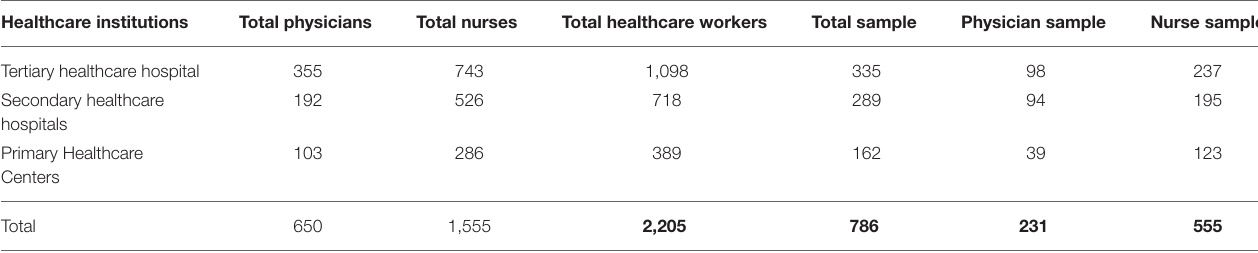
TABLE 1 | The sample size and sampling